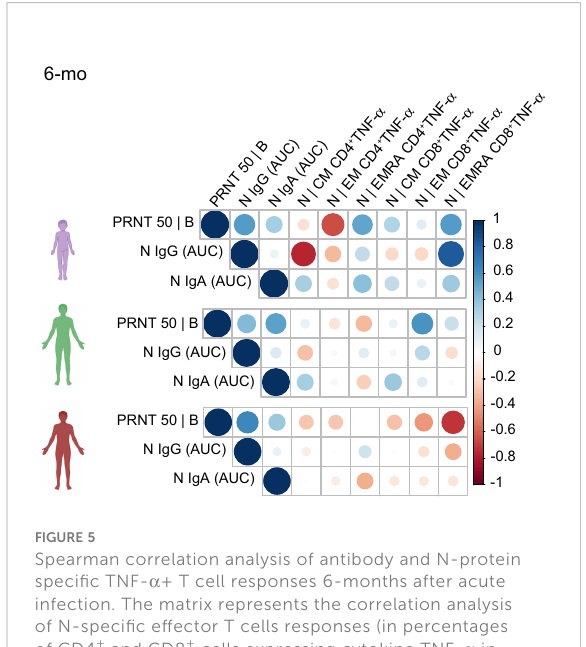
FIGURE 5 Spearman correlation analysis of antibody and N-protein speci fi c TNF- a + T cell responses 6-months after acute infection. The matrix represents the correlation analysis of N-speci fi c effector T cells responses (in percentages of CD4 + and CD8 + cells expressing cytokine TNF- a in response to the peptide pools), neutralizing antibodies to the B original variant, as well as the antibody response to the N protein (represented as values for the AUC – area under the curve). Total of 32 samples (children = 9, mild= 16, severe = 10).